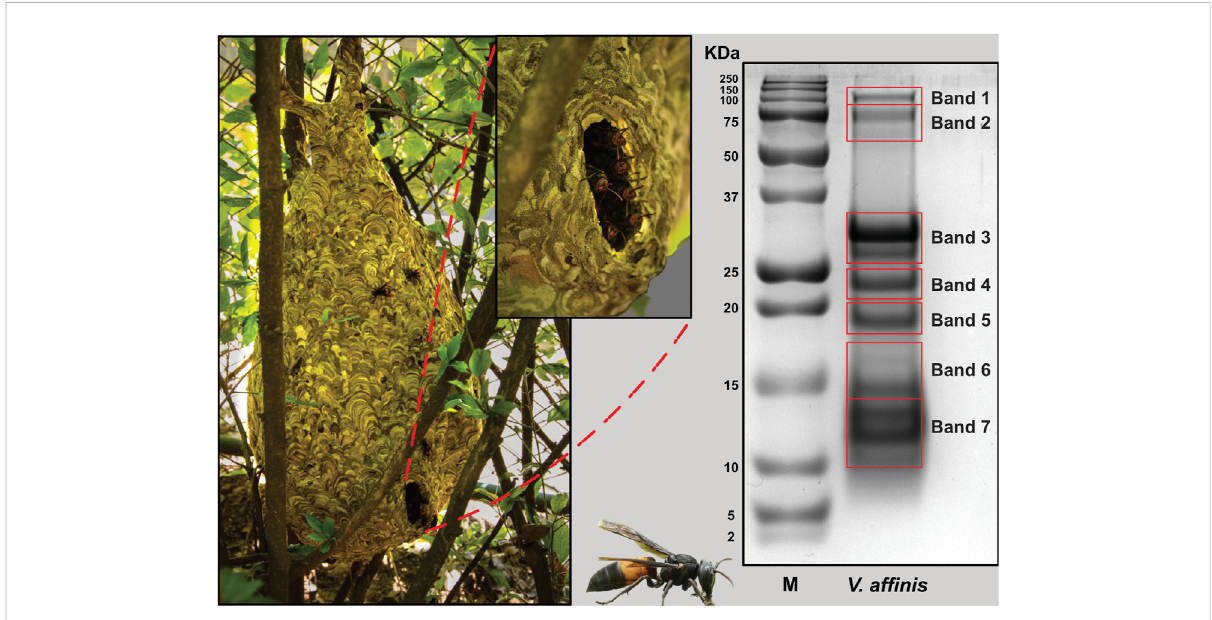
FIGURE 1 Thelesserbandedhornetanditsvenomcomposition.Imagesof V.af fi nis anditsnestareshown(panelA)alongsidetheSDS-PAGEpro fi leofthe venom (panel B). Red boxes in panel B are indicative of the bands that were excised for mass spectrometric